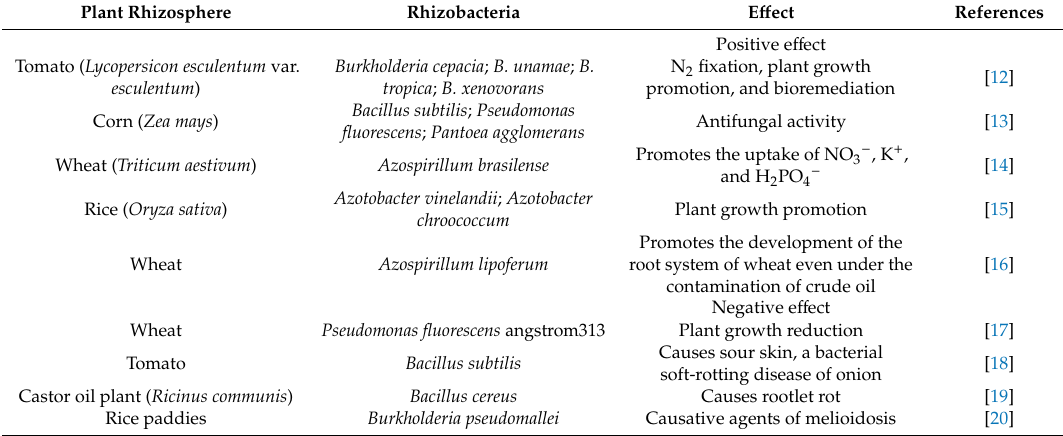
Table 1. Interactions occurring between the rhizosphere and bacteria can be positive, negative, or